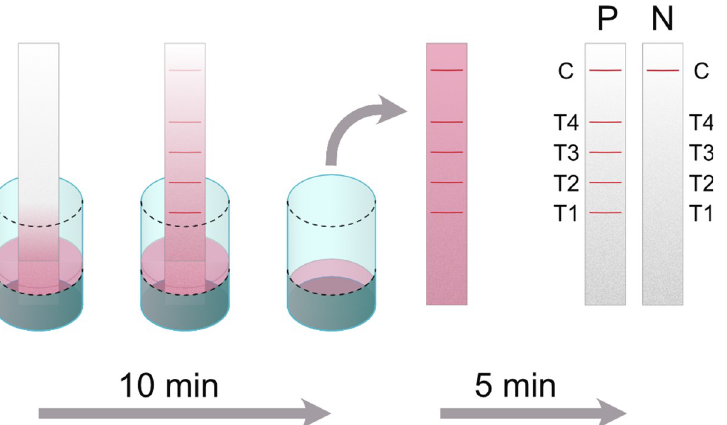
Fig 1. Melioidosis DS assay principle: A dipstick is placed into a well containing patient serum diluted in dipstick master mix (running buffer, detection antibody and control reagent). The mixture flows across the membrane for 10 minutes and patient antibodies labeled with gold-nanoparticle conjugated secondary antibody start to accumulate at the test lines, in case of a specific antibody response. Afterwards the assay is incubated for 5 minutes at room temperature to reduce the background resulting from the flow of the detection antibody. Negative samples only show a single control band, indicating proper assay performance, whereas up to 4 additional bands (T1 –T4) might be visible in case of a positive